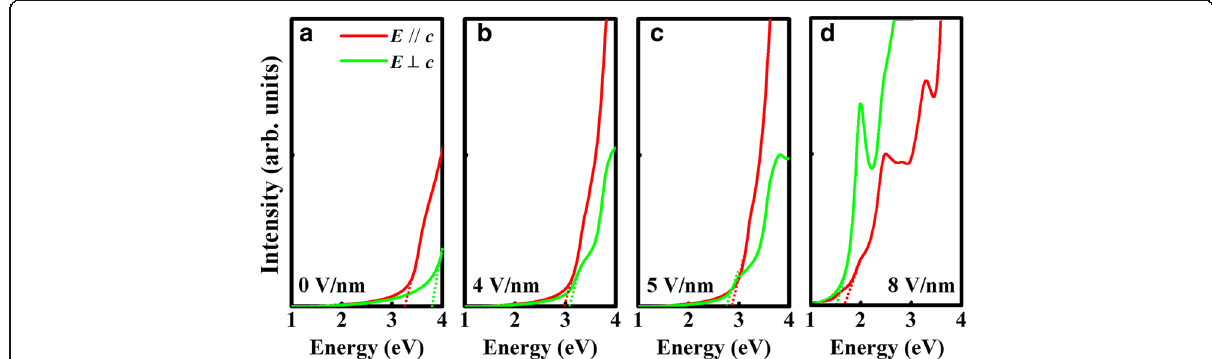
Fig. 2 The calculated optical absorption spectra of the GaS ML a without an external electric field and b – d with an external electric field of 4, 5, and 8 V/nm, respectively. The absorption edge is labeled. Red and green lines represent TM and TE light, respectively